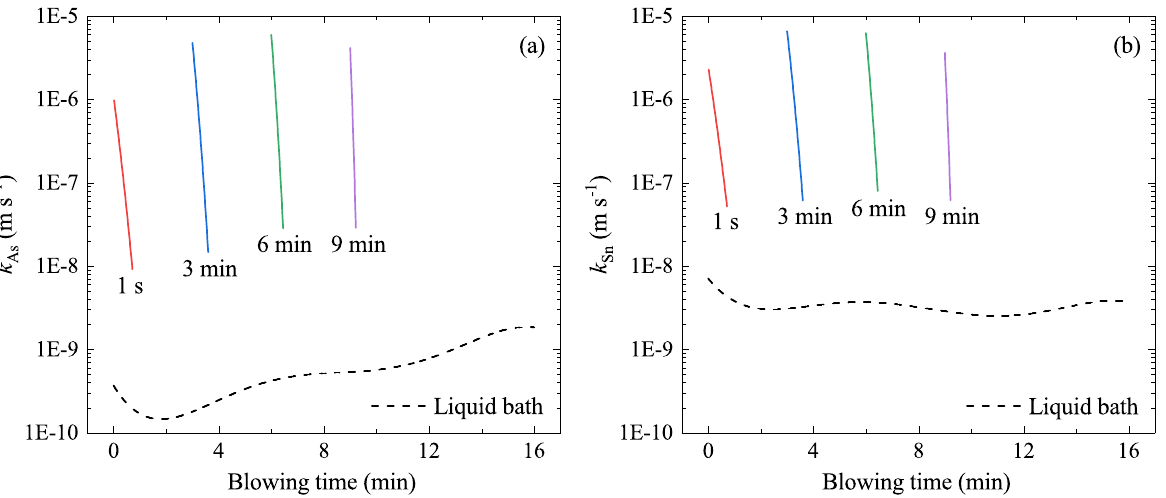
Figure 12. Change of the evaporation rate constant in the liquid bath and in the droplets ejected at t (cid:48) = 1 s, 3 min, 6 min, and 9 min, respectively, during the oxygen blowing: ( a ) k As ( b ) k Sn . Solid curves are those for the ejected droplets, and dashed curves are those for the liquid